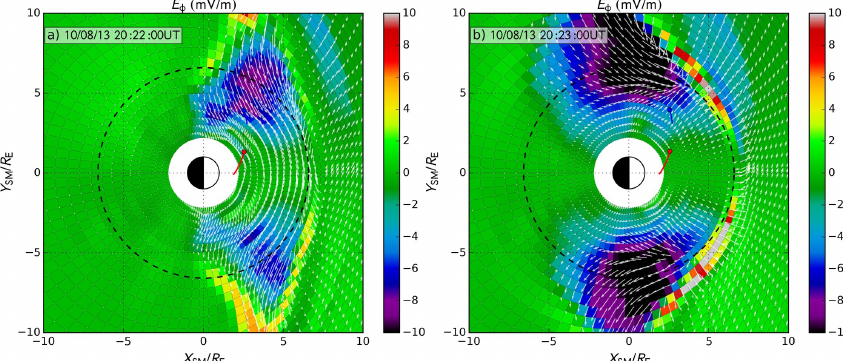
Figure 6. 8 October 2013 event: color-coded E φ component of electric field in SM equatorial plane shortly after the shock arrival at (a) 20:22 and (b) 20:23UT, with the electric field vectors overplotted as the white arrows. The locations of Van Allen Probes A (red) and B (blue) are represented by circles with past 30min of the trajectory represented by solid line of respective color. Bluer colors, which represent negative electric field, will transport electrons inwards while providing adiabatic heating of particles.